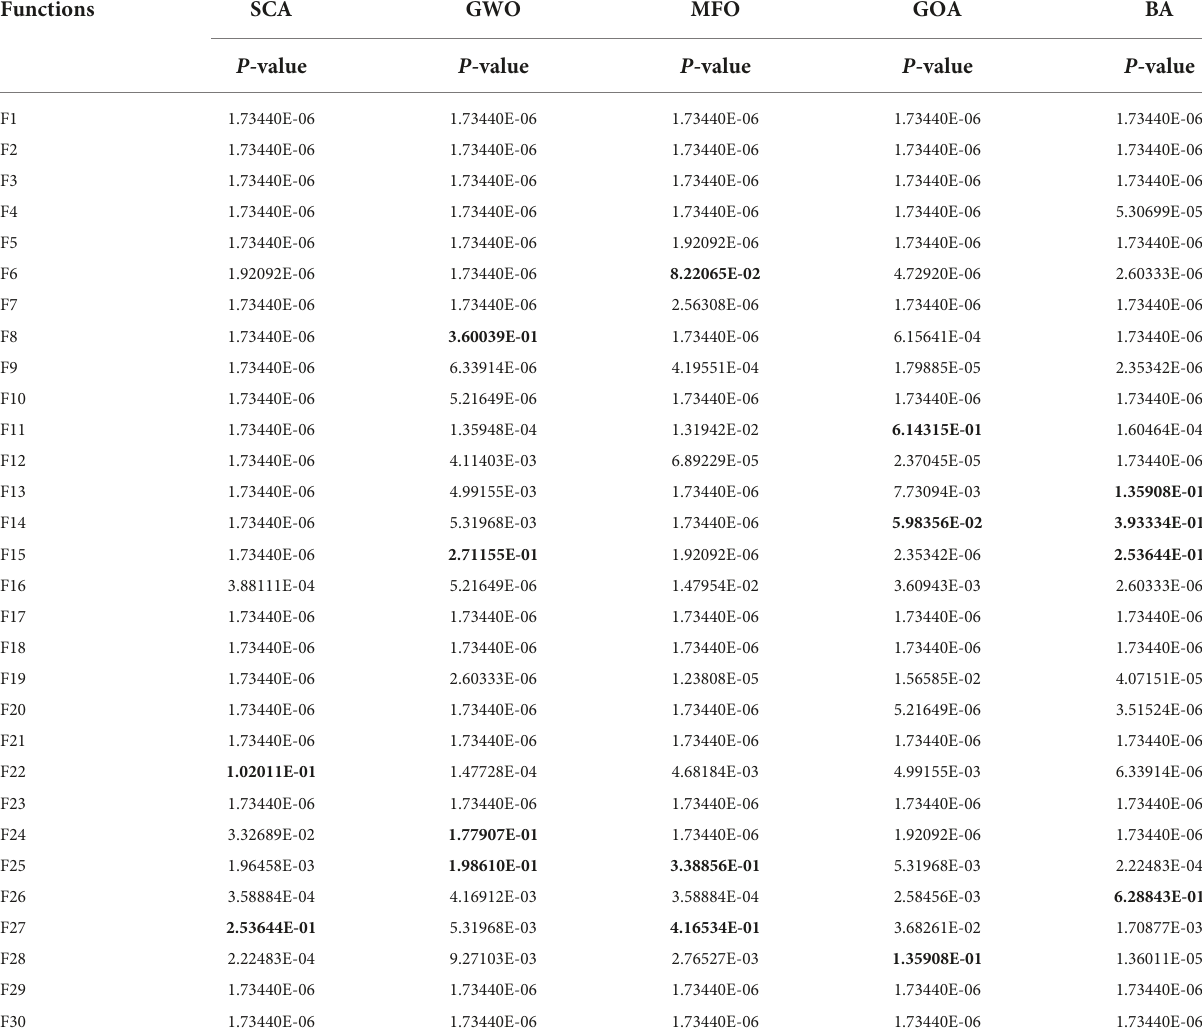
TABLE 10 P -values of COWOA vs. the well-known original algorithms on the Wilcoxon test.